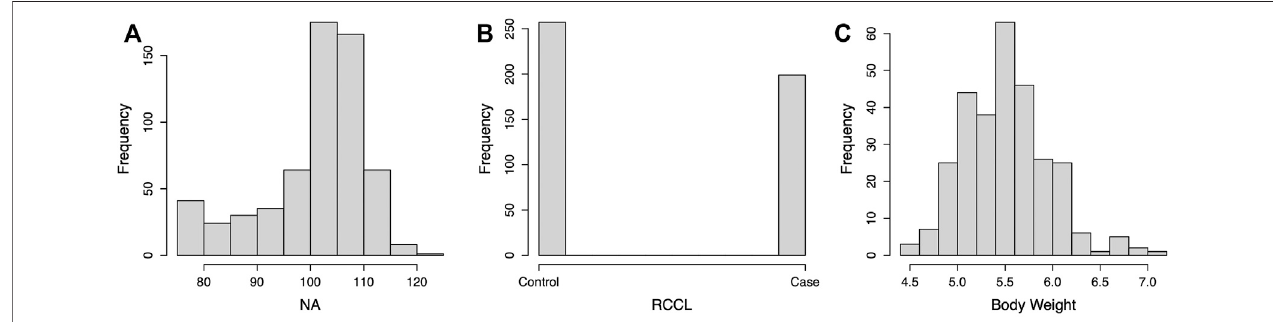
FIGURE 2 | Histogram of the phenotype distribution of canine hip dysplasia (CHD), rupture of cranial cruciate ligament (RCCL), and body weight. NA (cid:1) Norberg